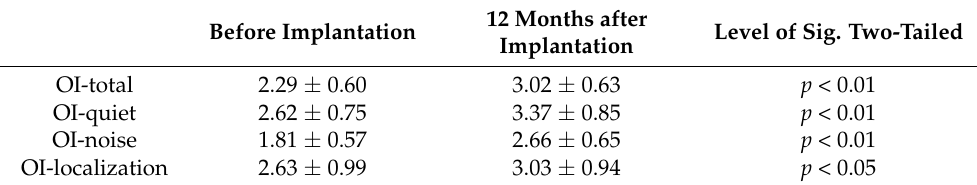
Table 1. Mean values (MVs) of the Oldenburg Inventory (OI) subscales before and 12 months after CIs. The level of significance indicates the difference between the examination points. The results are shown as MV ± SD. 12 Months after Before Implantation Level of Sig. Two-Tailed Implantation